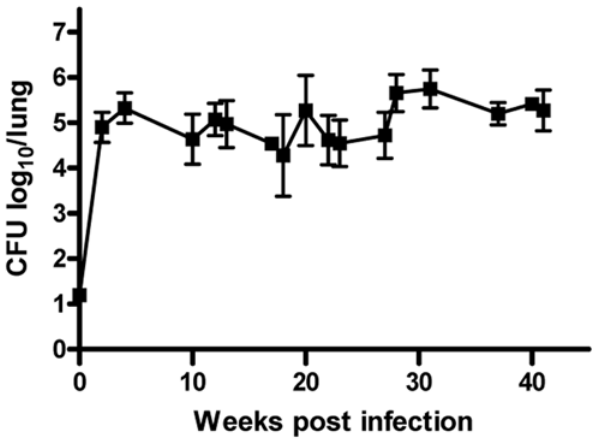
Figure 2. The bacterial load in the lungs throughout infection shown as Log10 CFU. Mice were challenged by the aerosol route with virulent M. tuberculosis . At the indicated timepoints 3–6 mice were killed and the bacterial burden (CFU) was measured in the lung.